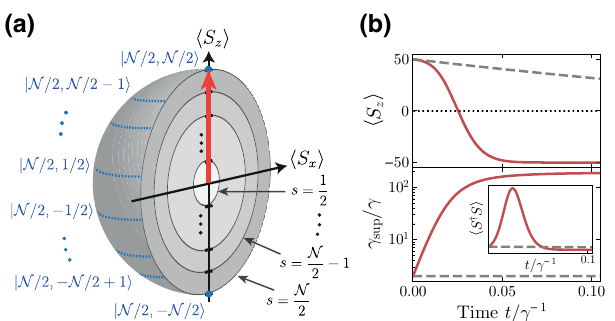
FIG. 4. (a) Cross section of collective N -emitter Bloch sphere (for an odd number of spins) showing an onionlike structure with Bloch vector (red) pointing towards the north pole represent- ing the fully excited state | E (cid:2) . The lines of latitude (blue dotted lines) correspond to the | N / 2, m N / 2 (cid:2) states. (b) Dicke super- radiance for N = 100 emitters initialized in the fully excited state | E (cid:2) . The top shows time dynamics of (cid:3) S z (cid:2) while the bottom shows the normalized decay rate γ sup = − ∂ t (cid:3) S z (cid:2) /( (cid:3) S z (cid:2) + N / 2 ) . The inset shows the time evolution of (cid:3) S † S (cid:2) with superradiant “burst” reaching a maximum when (cid:3) S z (cid:2) = m s reaches zero. The dashed gray lines show the result for pure exponential decay of independent, uncoupled